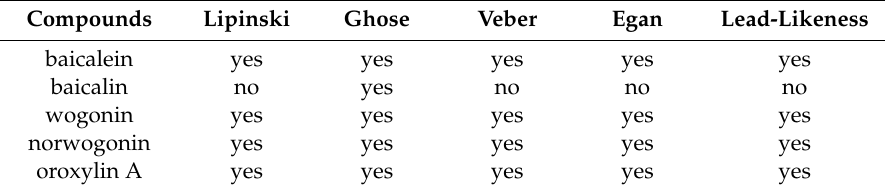
Table 3. The bioavailability, drug-likeness, and lead-likeness features of baicalein, baicalin, wogonin, norwogonin, and oroxylin